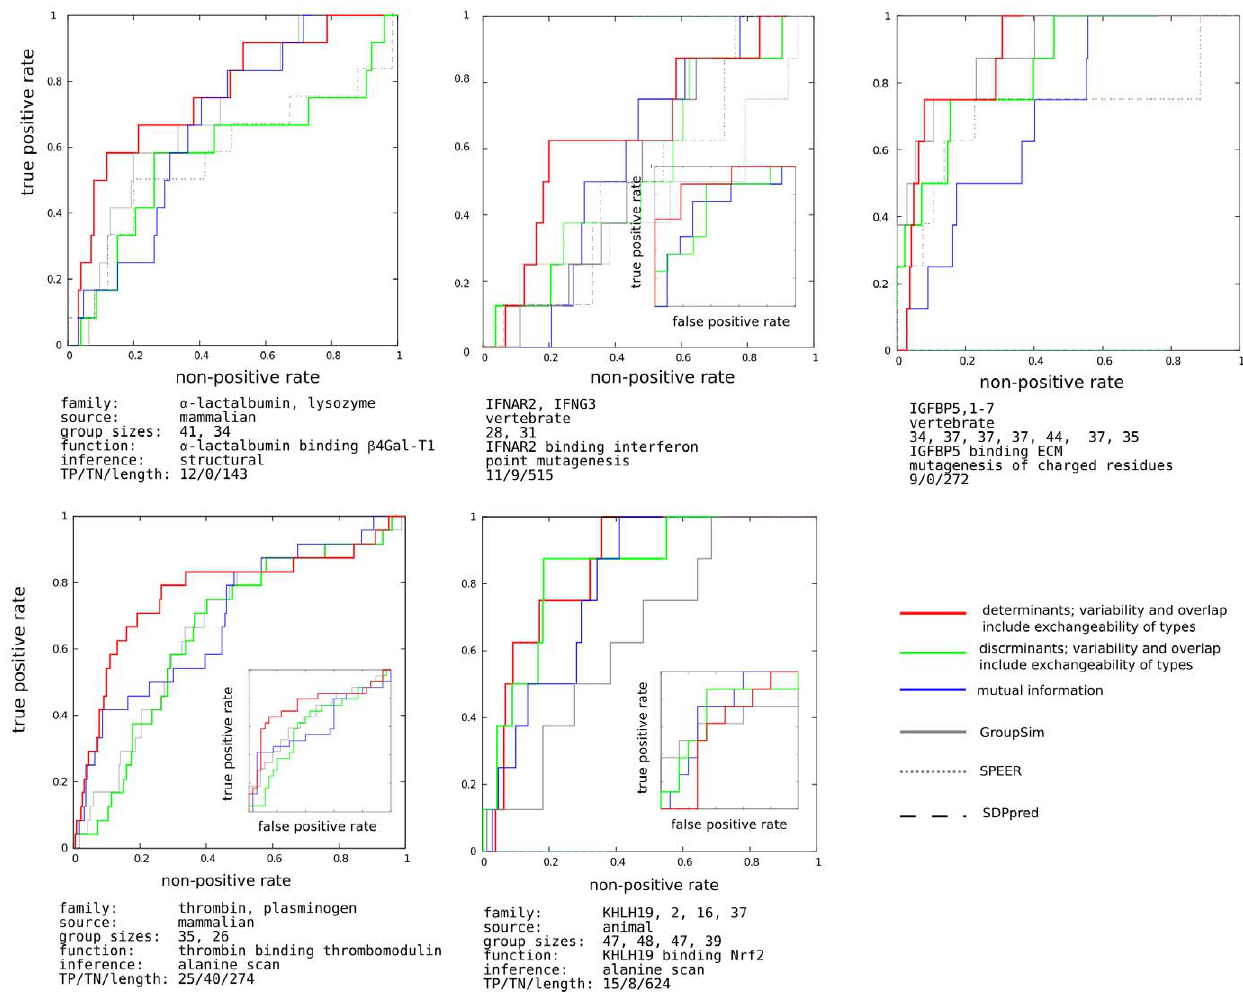
Figure 4. The same as Fig. 1, for protein-protein interaction cases.